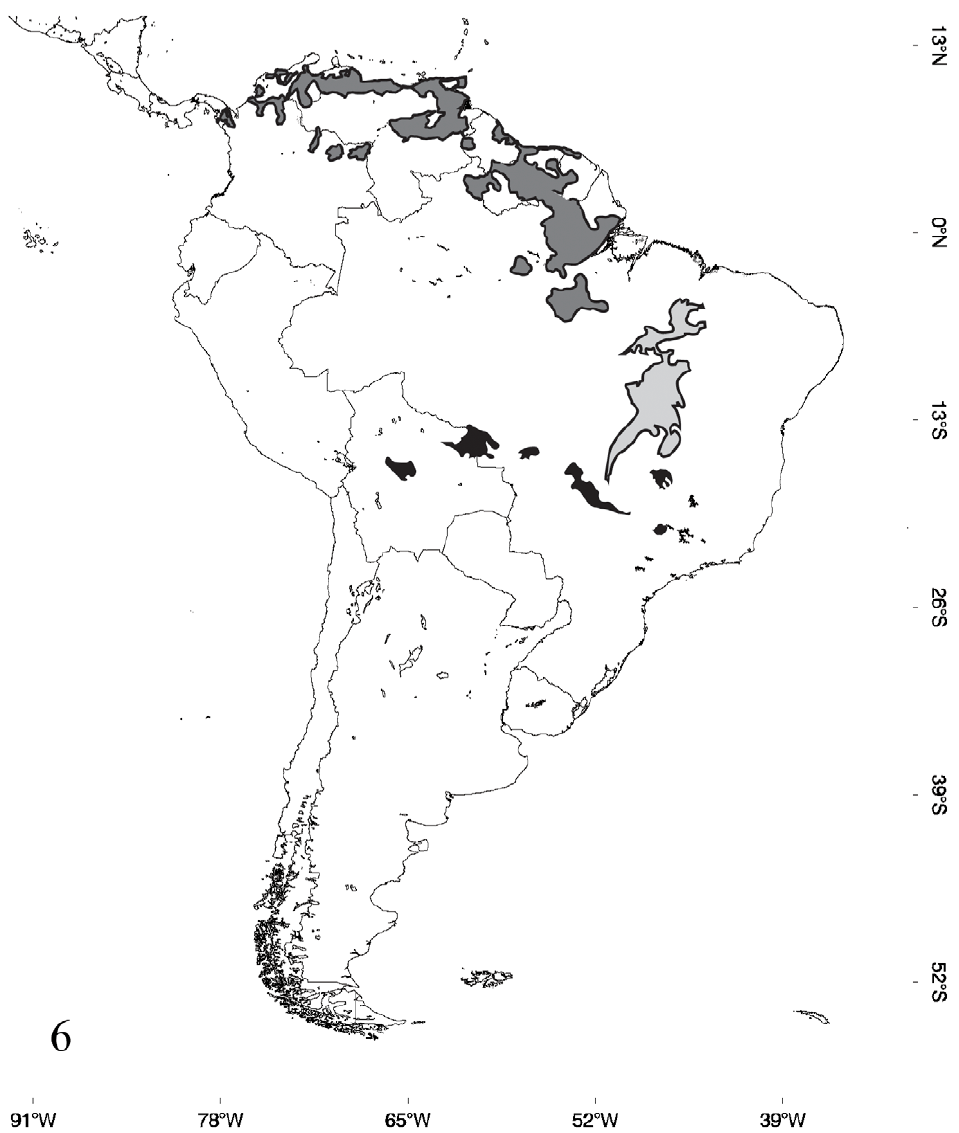
Figure 6. Occurrence probability maps of overlapping zones between species of continental Epicrates , determined by their respective models. Black areas depict overlapping between E. cenchria and E. crassus , dark gray areas between E. cenchria and E. maurus , and gray areas between E. cenchria and E. assisi .